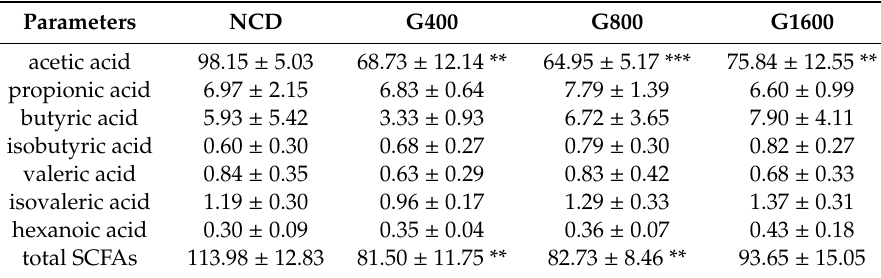
Table 3. E ff ect of GML on the concentrations of fecal